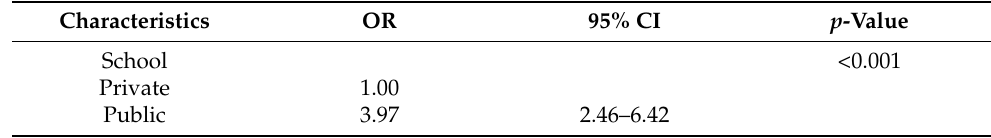
Table 3. Independent association between meeting the recommended MVPA level and predictor.